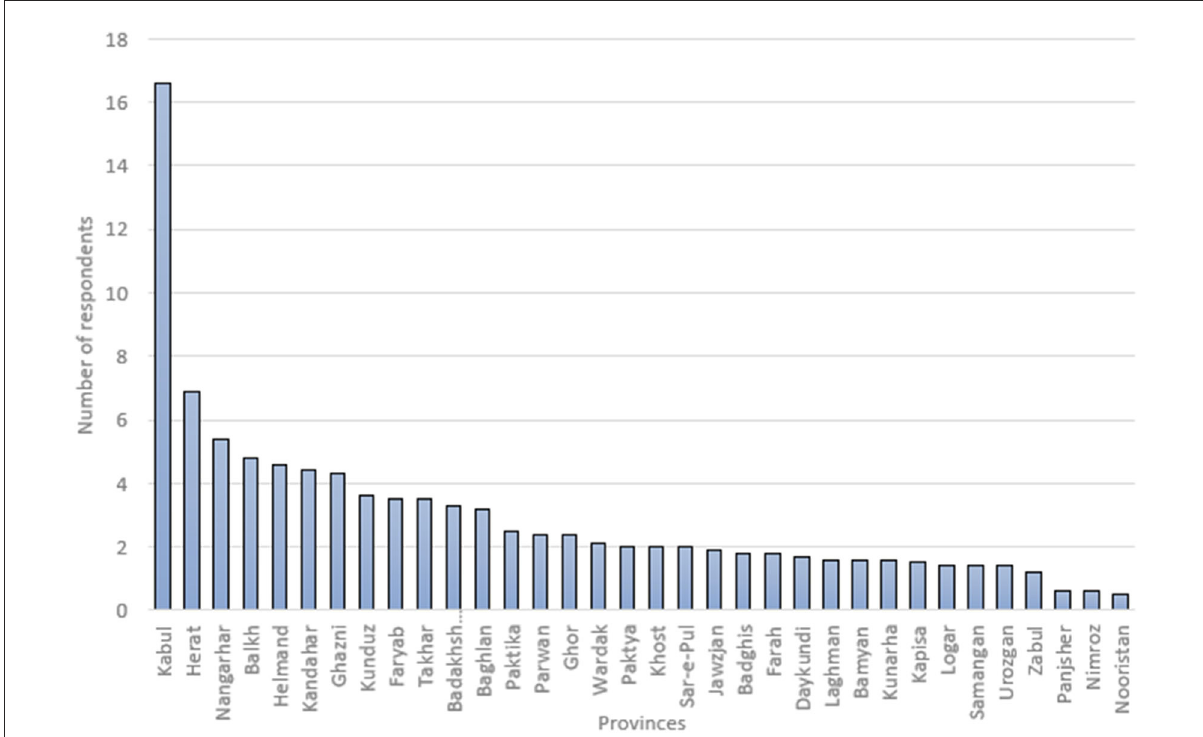
FIGURE1 Proportion of respondents per province in KAP